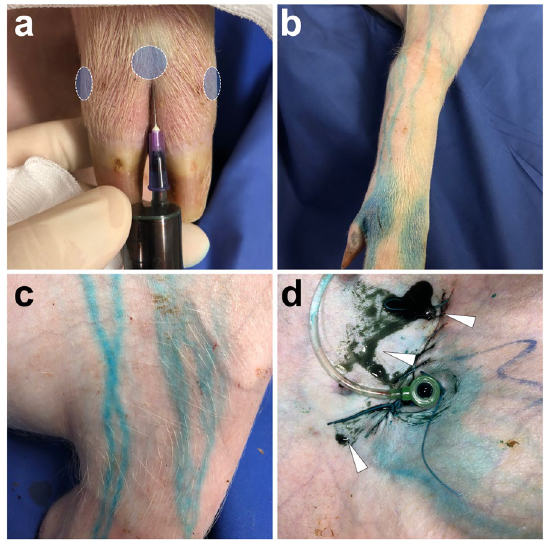
Fig. 2 Interstitial dye test with the PLL identification. Fifteen minutes after the interdigital ( imaginary circle ) injection of Patent Blue V ( A ) at the right foot (1 ml per each interdigital space), the subcutaneous lymphatic vessels at the lower limb ( B ) and thigh ( C ) were dyed blue color which could be visually observed. With more time, PLL could be identified by the blue dye extravasation ( white arrowheads ) from the incision around the arterial sheath ( D ). Images were from Pig No. 3 . Abbreviation: PLL, postoperative lymphatic